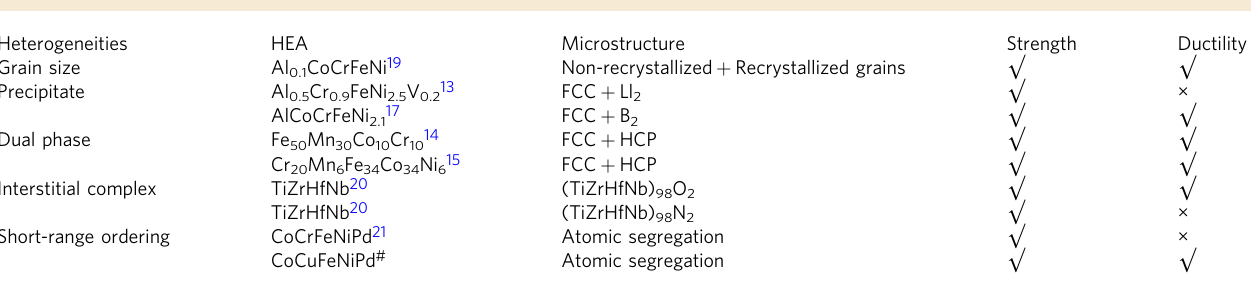
Table 1 Comparison of different approaches for the strength and ductility synergy in HEAs.